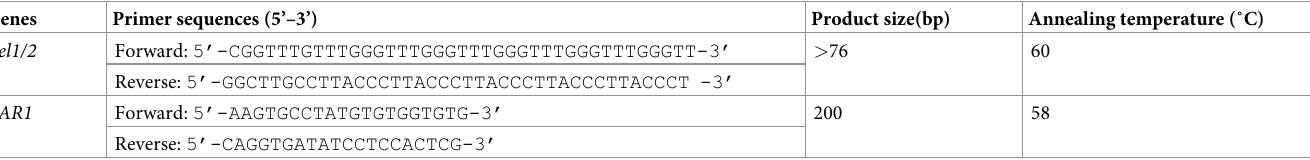
Table 1. Primer sequences for telomere